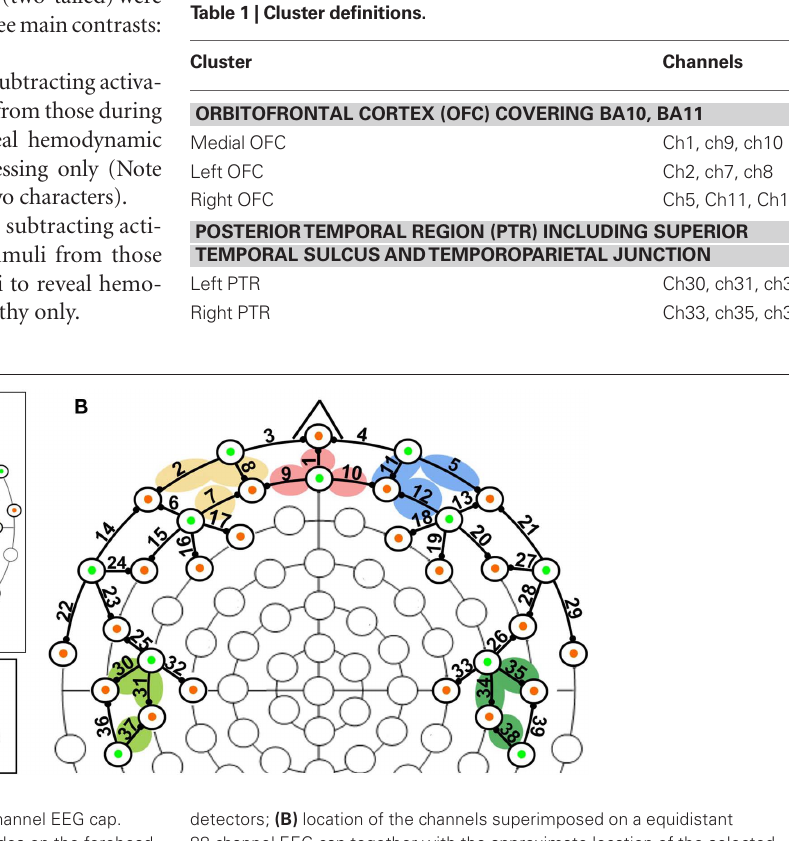
FIguRe 3 | (A) Optode positions on an equidistant 88-channel EEG cap. Note that the EEG cap was turned by 180 ° to place optodes on the forehead to be able to record orbitofrontal activation; green: sources, orange: